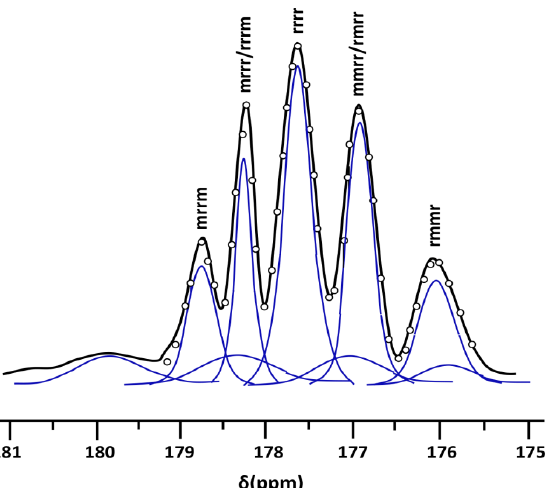
Figure 3. Deconvoluted 1 HNMR spectrum of PMMA in Laurentzian curves between 0.40 ppm and 2.20 ppm.